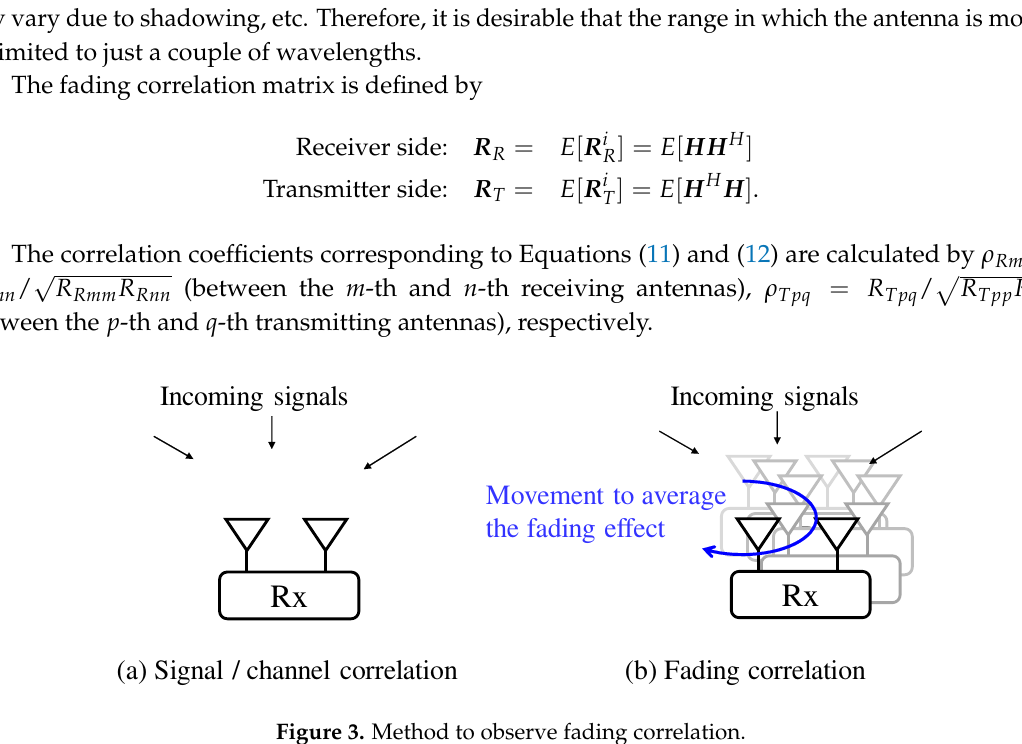
Figure 3. Method to observe fading